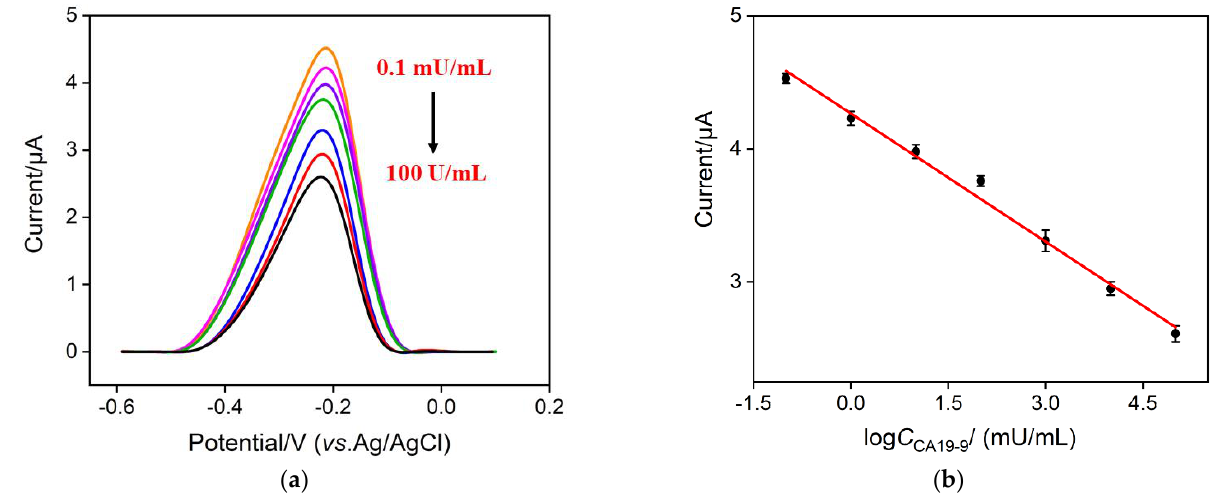
( d ) Figure 7. ( a ) CV and ( b ) EIS plots of different electrodes in 0.1 M KCl solution containing 2.5 mM Fe(CN) 63 – /4 – . ( c ) CV and ( d ) DPV curves of different electrodes in 0.01 M PBS (pH = 7.4). 2.6. Electrochemical Determination of CA19-9 CA19-9 was detected by DPV based on the decrease of the electrochemical signal of MB after CA19-9 binding, and the results were shown in Figure 8. As shown, after incu-